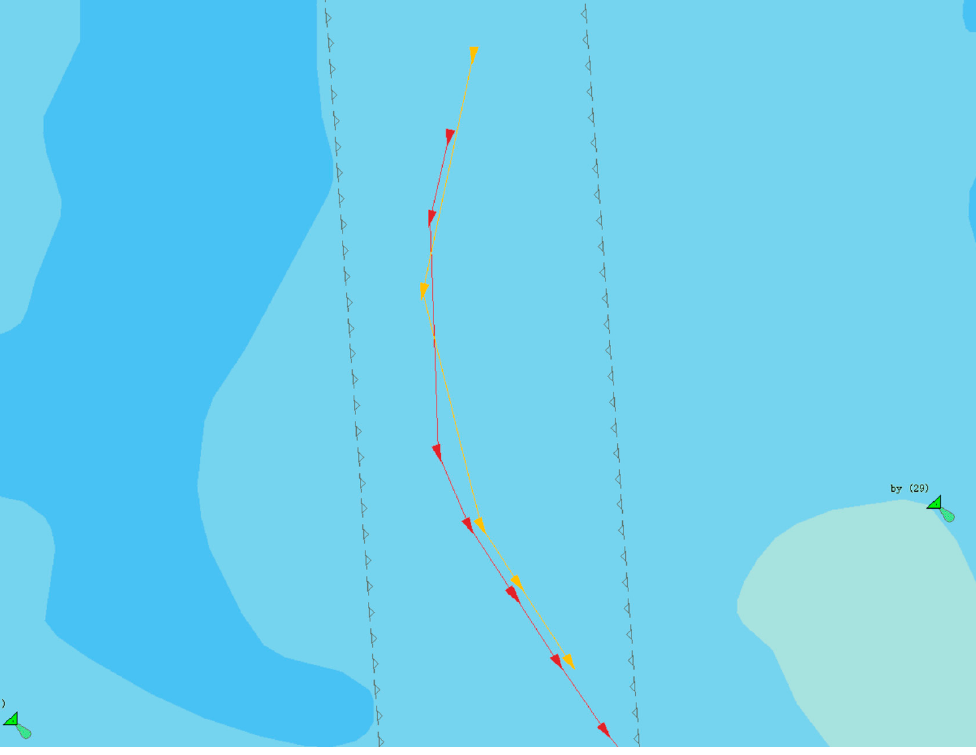
Figure 21. Schematic diagram of the USV collision-avoidance process (2).